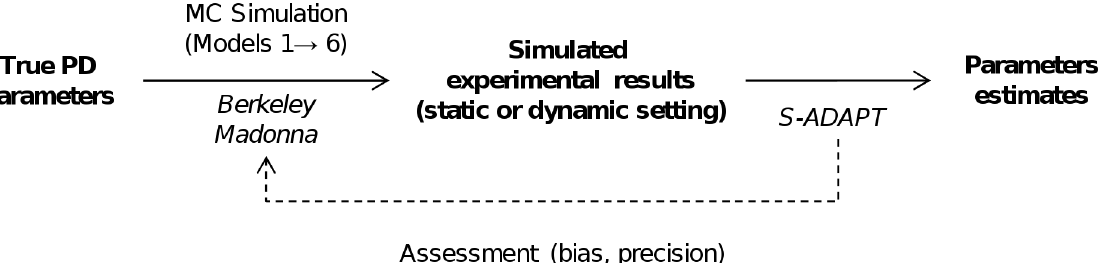
Fig 1. Simulation-estimation flow chart. Based on a set of true PD parameter values, Monte Carlo (MC) simulations were performed using six PD models to generate experimental datasets under both static and dynamic conditions. Each of these datasets was then estimated via population PK/PD modeling in S-ADAPT for each of the six models (yielding 36 simulation-estimation scenarios in total). The parameter estimates for each model were compared to the true parameter values used during simulation to assess bias and precision.